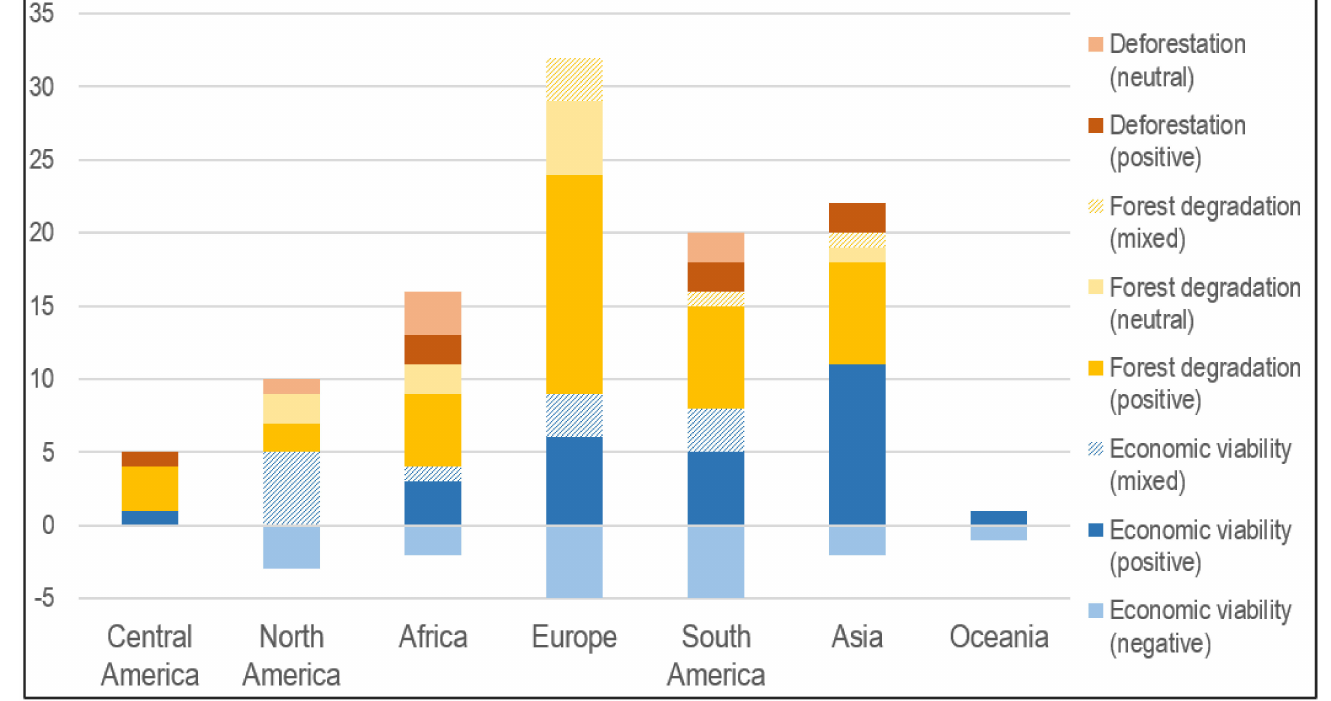
Figure 11. Distribution of case studies and their reported impact on deforestation, forest degradation and economic